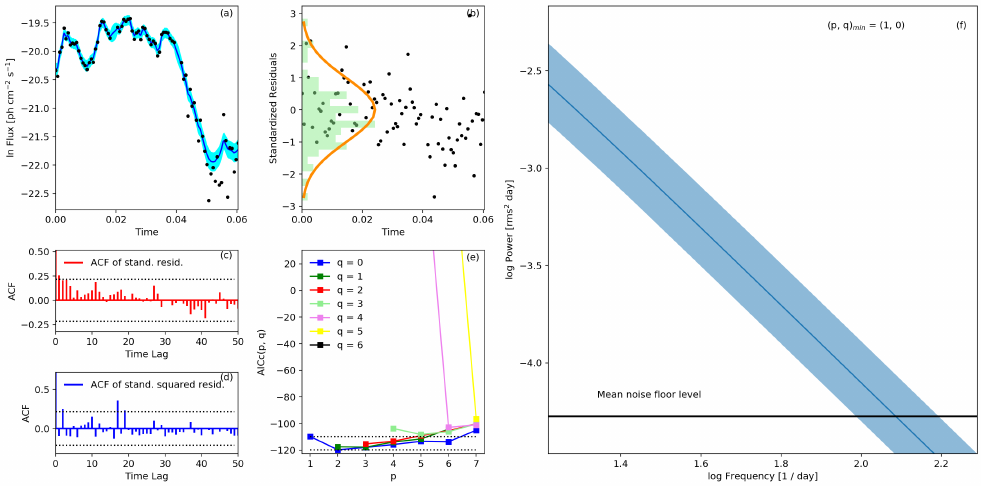
Figure 3. Results of CARMA modeling on the intra-night light curve (Figure 1b). The layout is the same as that of the Figure 2. P stat is 0.000053 rms 2 day, which corresponds to a mean (=median, in this case) sampling interval of 1.1min. The best-fit CARMA model is obtained for p , q =